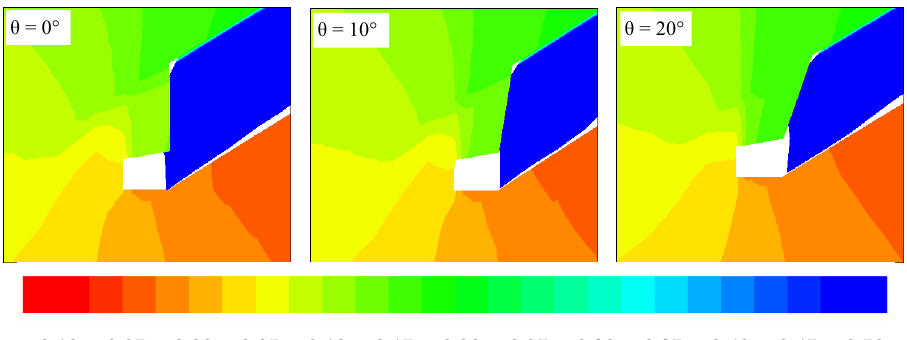
Figure 11. Vertical displacement cloud diagram of surrounding rock of entry.